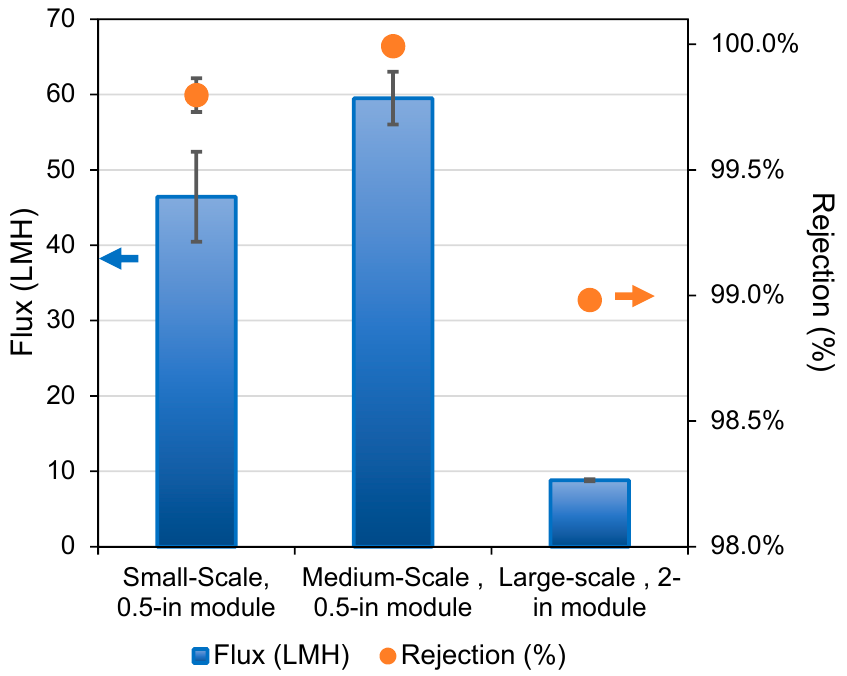
Figure 7. Flux and rejection of VMD tests in each batch using PVDF 1. All tests were performed for time ≥ 1 h using 0.5-inch modules and time ≥ 100 h using 2-inch modules. Small scale: 1.5 kg batch; medium scale: 20 kg batch; large scale: 50 kg .